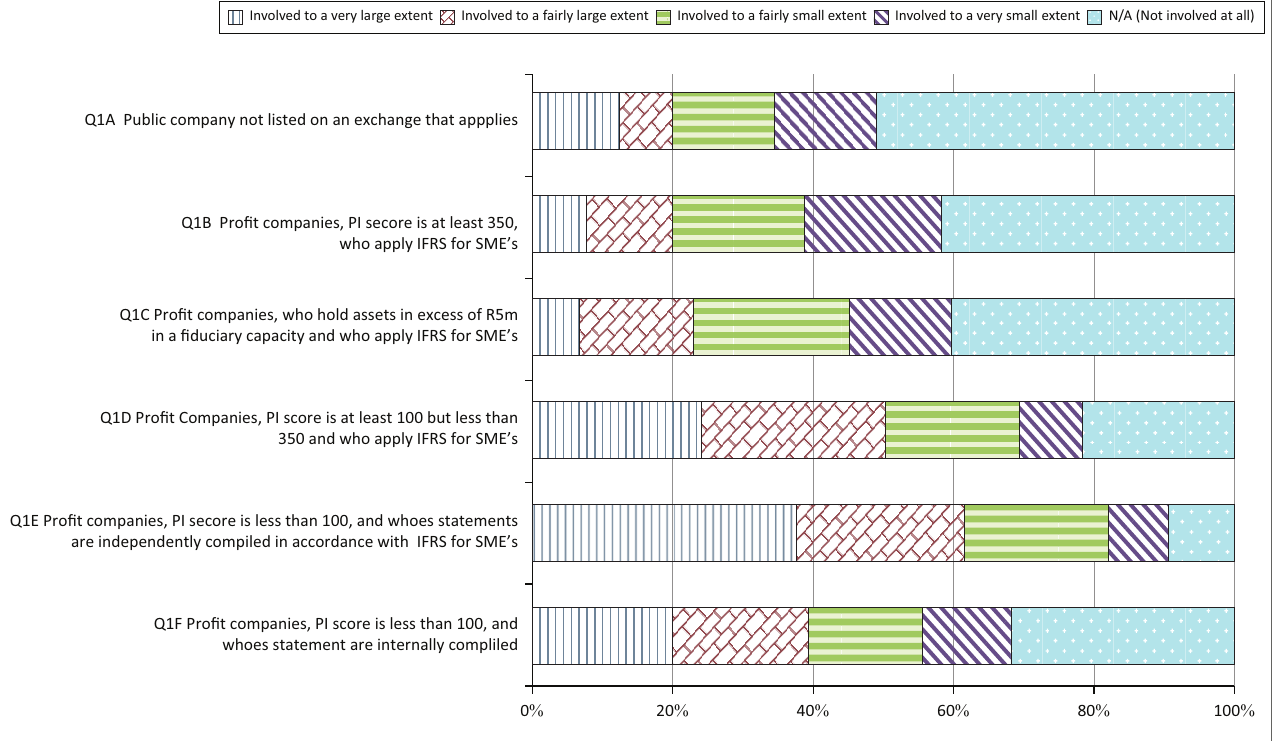
FIGURE 1: Respondents’ involvement with unlisted and non-publicly accountable